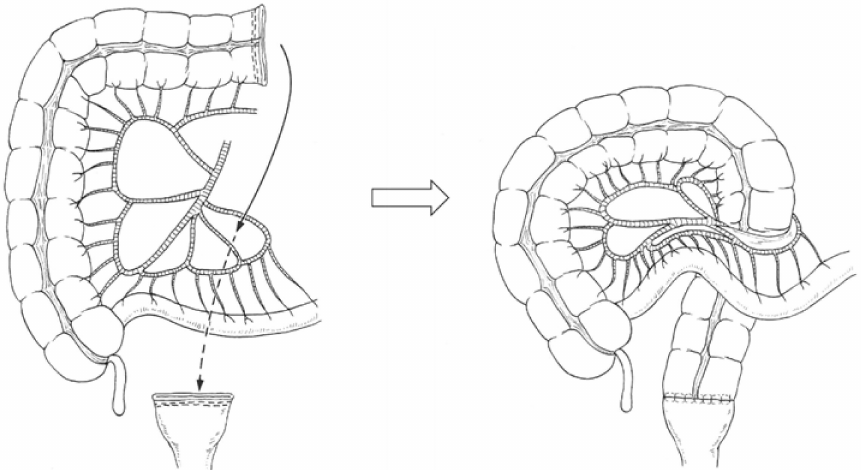
Figure 2. Retro-ileal anastomosis through an ileal mesenteric defect for colorectal anastomotic techniques after left hemicolectomy with rectal low anterior resection. The transverse or right colon is passed through a window created in an avascular area of the distal ileal mesentery to reach the rectal